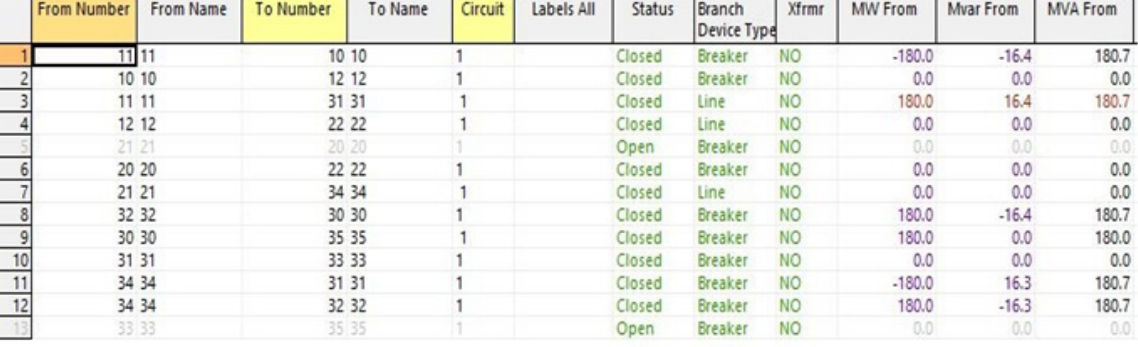
Figure 9. Measurement values of the transmission line under attack scenario III.